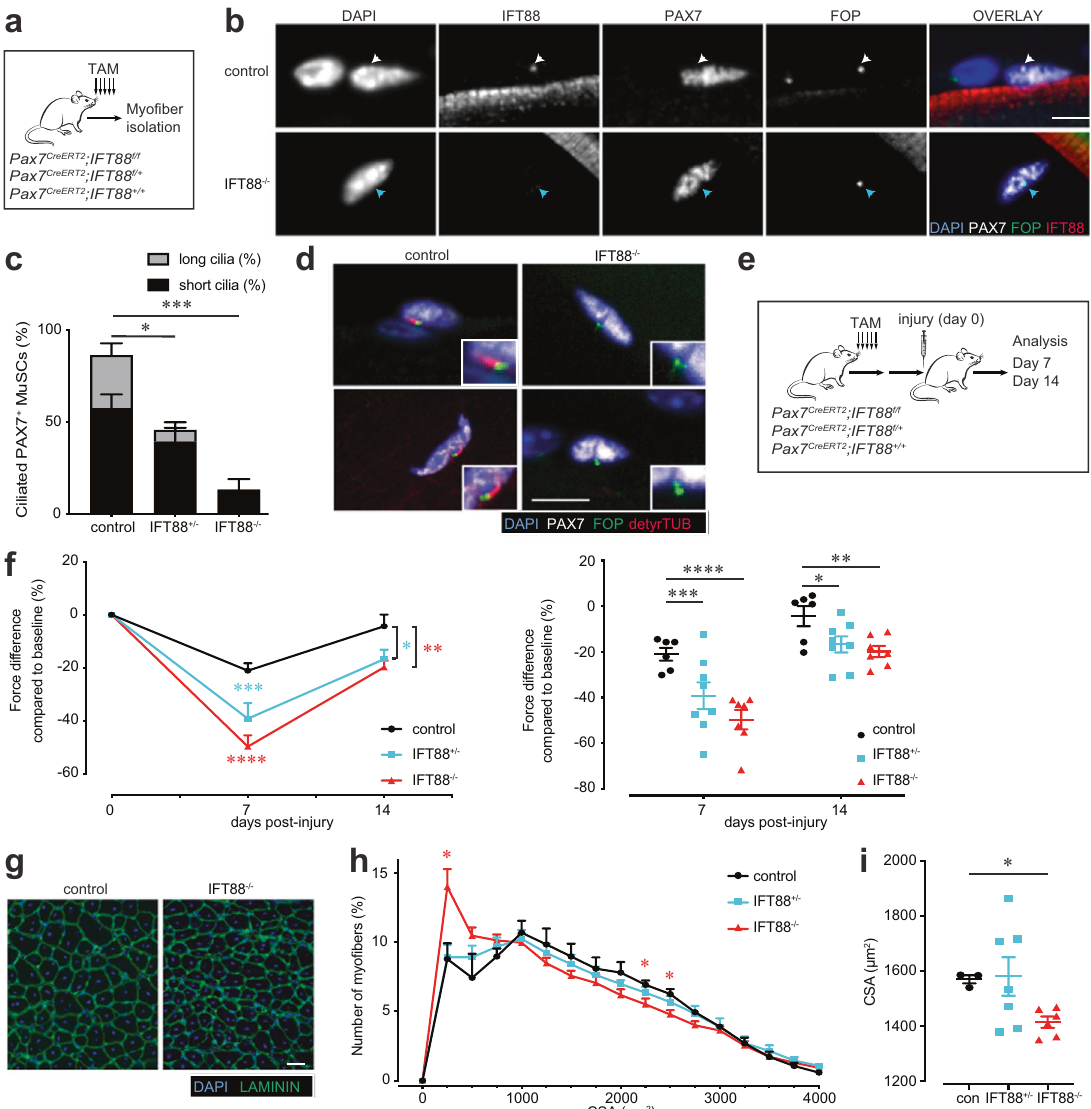
Fig. 1 Loss of primary cilia in MuSCs impairs muscle regeneration and strength recovery. a Pax7-speci fi c Ift88 conditional knockout mice ( Pax7 CreERT2 ;IFT88 f / f , IFT88 − / − ) , heterozygous mice ( Pax7 CreERT2 ;IFT88 + /f , IFT88 + / − ) or control littermates ( Pax7 CreERT2 ;IFT88 + / + , control, con ) were treated with tamoxifen (TAM) at 8 weeks of age. Myo fi bers were isolated and stained for ciliary markers. b Representative confocal images of control and IFT88 − / − myo fi bers showing IFT88 and FOP staining in PAX7 + MuSCs. All cells stain positive for the centrosomal marker FOP. Scale bars: 10 μ m. DAPI, blue; PAX7, white; FOP, green; IFT88, red. White arrowheads indicate the presence of IFT88 in the primary cilium on the surface of MuSCs. Blue arrowheads indicate MuSCs lacking cilia. Quanti fi cation in Supplementary Fig. 1b. c , d Visualization of MuSC cilia using detyrosinated tubulin to stain the ciliary axoneme and FOP to visualize the ciliary base. All cells stain positive for the centrosomal marker FOP. Absence of detyrosinated tubulin is scored as no cilia. c Percent of short (<1 µ M) and long (>1 µ M) cilia on Pax7 + MuSCs quanti fi ed from isolated myo fi bers of control, IFT88 + / − and IFT88 − / − mice ( n = 75 control, 79 IFT88 + / − , 81 IFT88 − / − total myo fi bers were analyzed from 4 independent mice per genotype; average percent of ciliated MuSCs per mouse is shown, individual data points in Supplementary Fig. 1c). d Representative confocal images of uninjured/resting EDL myo fi bers of control and IFT88 − / − mice showing cilia immunostaining in Pax7 + MuSCs. Scale bars: 10 μ m. DAPI, blue; PAX7, white; FOP, green; detyrosinated tubulin, red. e – i Control, IFT88 + / − and IFT88 − / − mice were injured with notexin and analysis was performed 7 or 14 days post-injury ( n = 3 control mice; n = 4 IFT88 + / − and IFT88 − / − ; two legs per mouse). e Experimental scheme. f Plantar fl exion tetanic torque of control, IFT88 + / − and IFT88 − / − mice on day 7 and day 14 post-injury (values normalized to baseline torque). g Representative Gastrocnemius (GA) cross-section at 14 days post-injury from control and IFT88 − / − mice. DAPI, blue; LAMININ, green. Bar = 50 µ m. h Myo fi ber cross-sectional areas (CSA) in control, IFT88 + / − and IFT88 − / − GAs ( n = 3 for control, n = 6 for IFT88 + / − and n = 6 for IFT88 − / − ). i Mean CSA. * P <0.05, ** P <0.01, *** P <0.001 **** P <0.0001. ANOVA test with Fisher ’ s LSD test for multiple comparisons ( c , f , h , i ). Source data are provided as a Source Data fi le. Means +